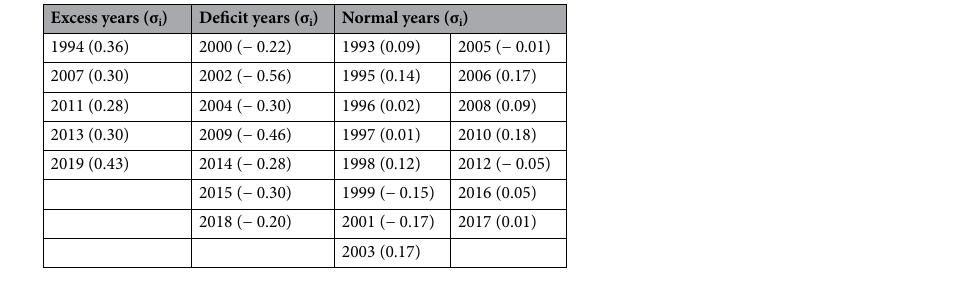
Table 3. Details of normal, deficit and excess monsoon years during